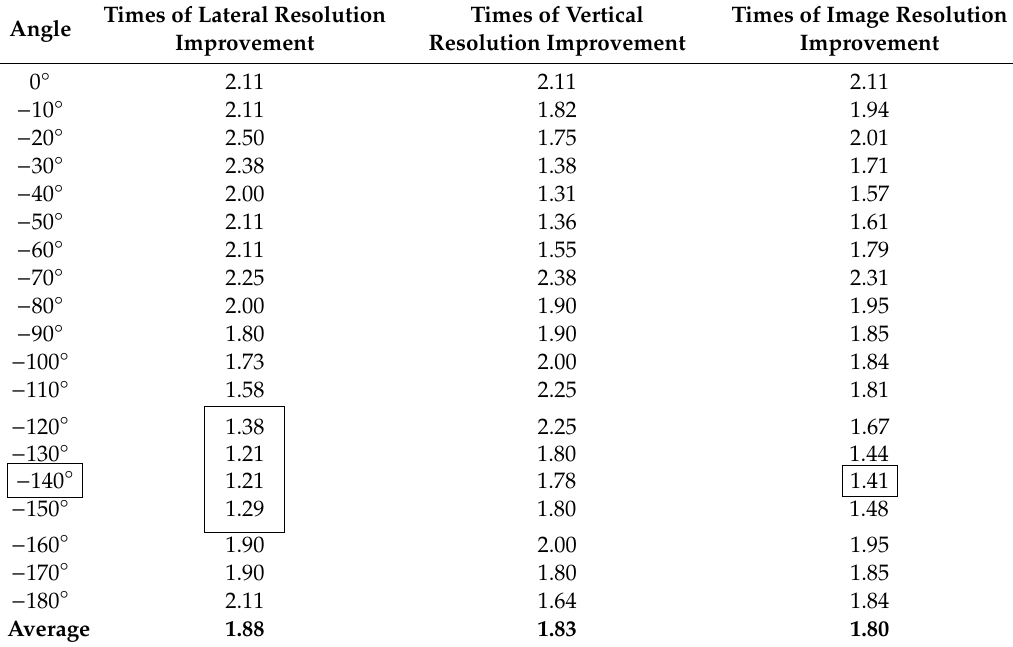
Table 2. Comparison of counterclockwise rotation resolution improvement